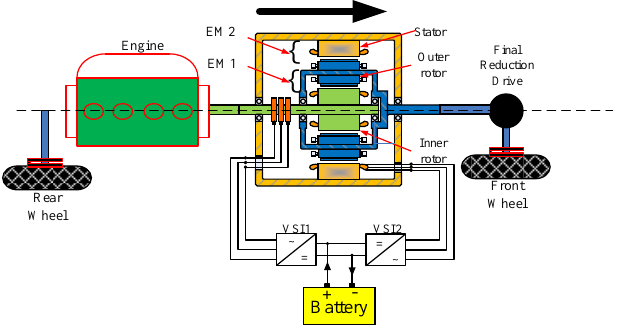
Figure 8. Schematic diagram of the vehicle model.